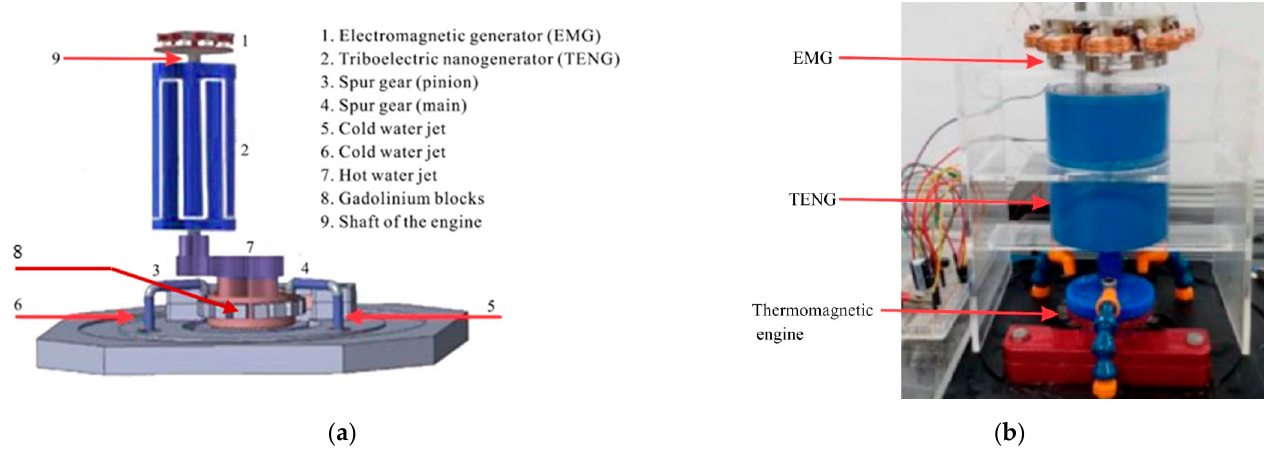
Figure 7. Schematic ( a ) and fabricated model ( b ) of hybridized EMG and TENG